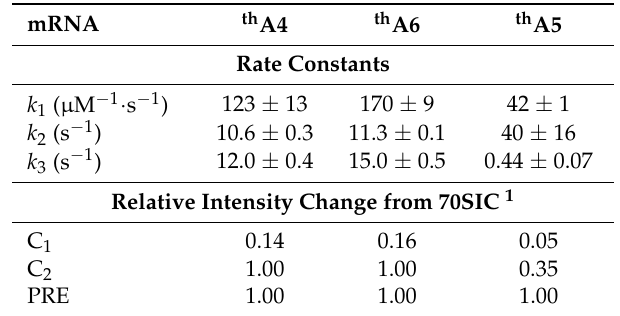
Table 2. Microscopic rate constants fit to Scheme 1 and relative th A fluorescence intensity changes.